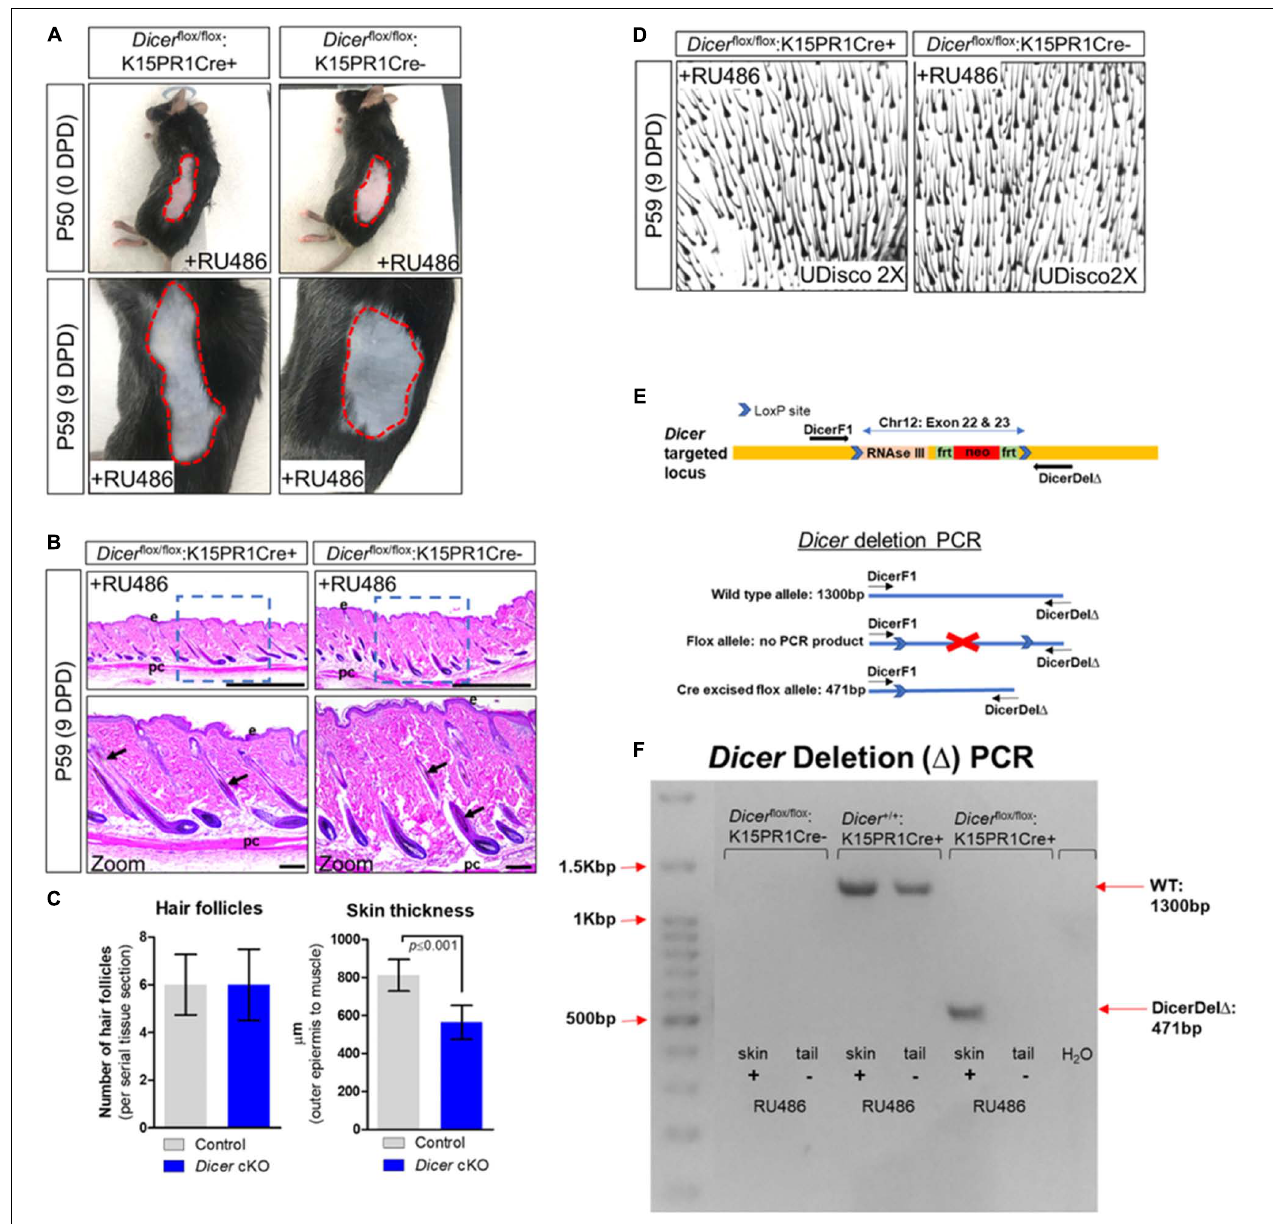
FIGURE 2 | Conditional knockout of Dicer within hair follicle bulge stem cells. (A) Images of the depilated regions of control ( Dicer flox / flox ;K15PR1Cre–) and experimental ( Dicer flox / flox ;K15PR1Cre+) mice at 0 days post depilation (DPD) and 9DPD. (B) Histological analysis of 9DPD skins in both control ( Dicer flox / flox ;K15PR1Cre–) and experimental ( Dicer flox / flox ;K15PR1Cre+) mice. Boxed region is magnified in the lower panels. Thickness measured from the panniculus carnosus (pc; muscle) to the outer epidermal layer (e). Bars (top panels = 1 mm; bottom panels = 100 um). (C) Hair follicle count and skin thickness analysis. Serial skin sections were assessed from control and Dicer cKO mice ( n = 12; p ≤ 0.001, Student’s t test). (D) Whole-mount uDISCO analysis of 9DPD skins in both control ( Dicer flox / flox ;K15PR1Cre–) and experimental ( Dicer flox / flox ;K15PR1Cre+) mice. (E) Schema of the targeting construct for generation of Dicer floxed mice. (F) Dicer deletion PCR using RU486 pre- and post-treated tissue samples. Refer to E, schema of the PCR strategy to determine Dicer ablation efficiency within tissue